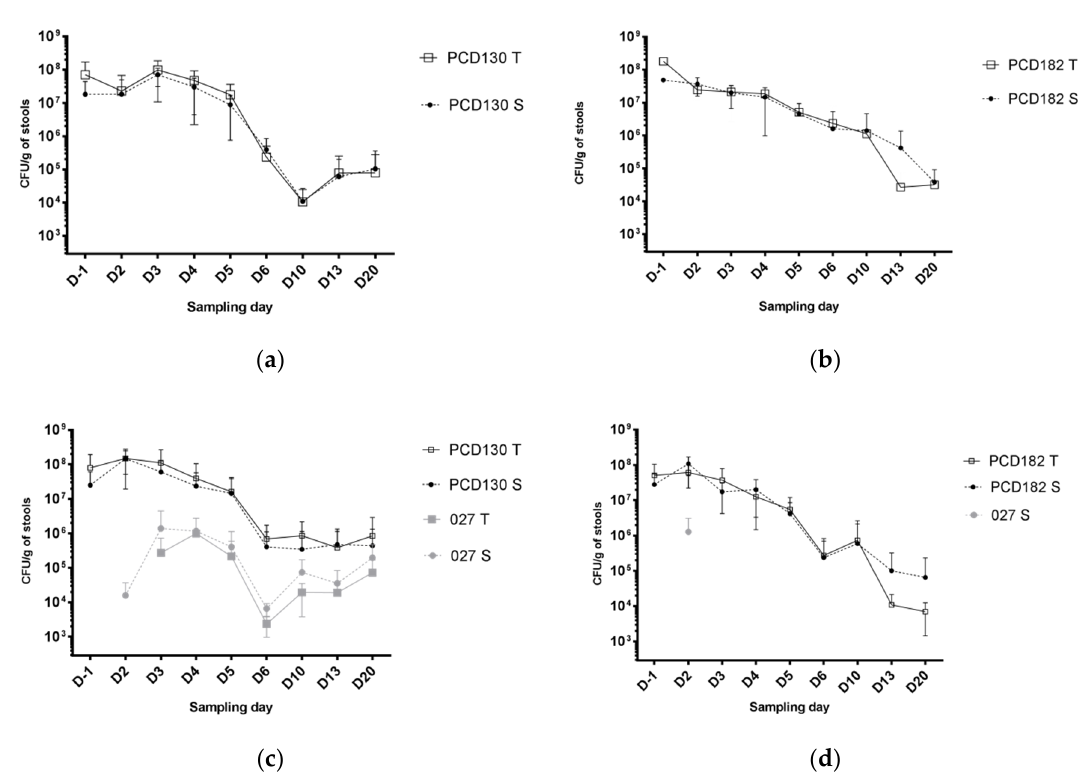
Figure 6. Mean colonization levels over time among colonized hamsters in the PCD130 ( a ), PCD182 ( b ), PCD130 + 027 ( c ) and PCD182 + 027 ( d ) groups (respectively B, C, D and E). T: total forms; S: sporulated forms. Error bars represent the standard deviation. The value for the group C at D-1 ( b ) is the observed count for the only colonized animal, therefore no error bar is